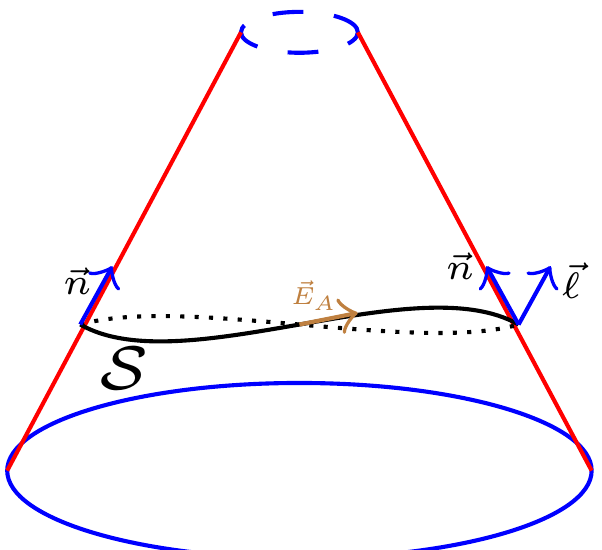
Figure 1. This is a schematic representation of J + when Λ = 0, where (cid:126) n is the null degeneration vector field, S is a cut, (cid:126)(cid:96) is the unique null vector orthogonal to S and transversal to J , and (cid:126) E A are vector fields tangent to the cut. Cuts are two-dimensional surfaces, usually with S 2